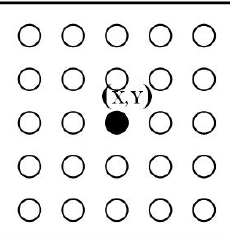
, Kr , Kr and Kr 1 2 3 4